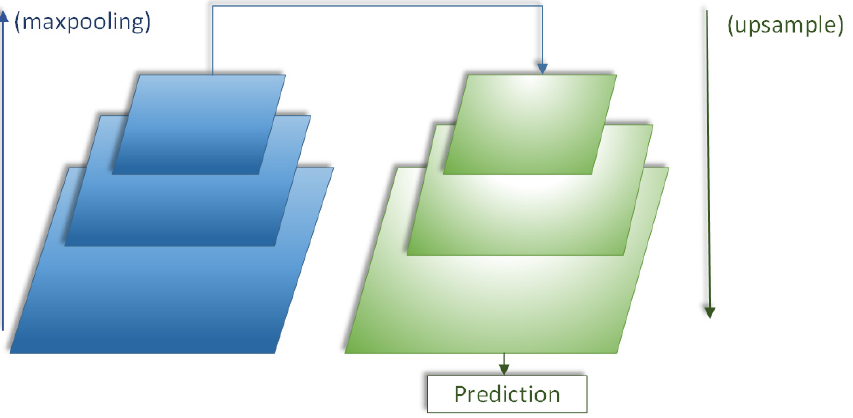
Figure 2. Top-level feature prediction structure.